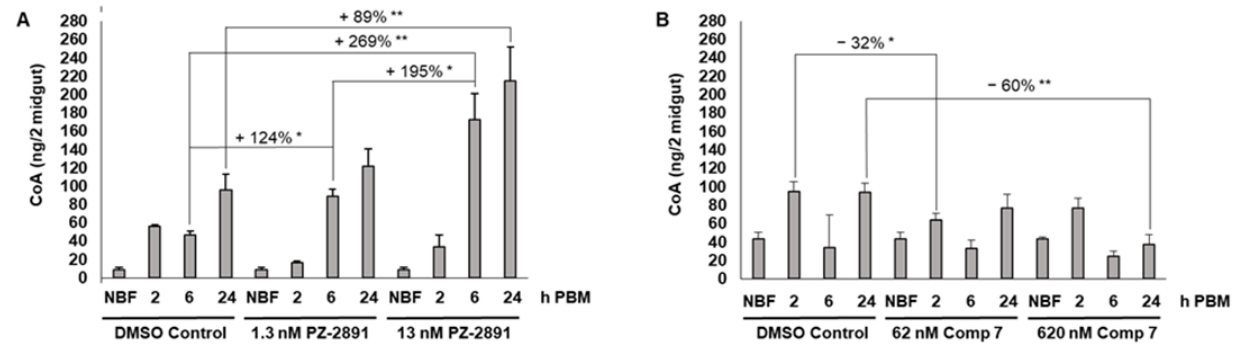
Figure 4 . Oral provisioning of PZ-2891 increased and compound 7 decreased A. stephensi midgut CoA levels, respectively. ( A ) . Mosquitoes provisioned with PZ-2891 had significantly increased levels of midgut CoA at 6 h (13 nM and 1.3 nM) and 24 h (13 nM) relative to DMSO control, with a pattern of greater increases in midgut CoA for 13 nM vs. 1.3 nM PZ-2891 at 6 h and 24 h. Differences between treatments and controls were evaluated using Student’s t-test. ** p < 0.01 and * p < 0.05. Three distinct biological cohorts of mosquitoes were assayed. ( B ) . Mosquitoes provisioned with 620 nM and 62 nM compound 7 had reduced levels of midgut CoA at 24 h and 2 h, respectively, relative to DMSO control. Five distinct biological cohorts of mosquitoes were assayed. Differences between treatments and DMSO controls were evaluated using Student’s t-test. ** p < 0.01 and * p < 0.05. Five distinct biological cohorts of mosquitoes were assayed.